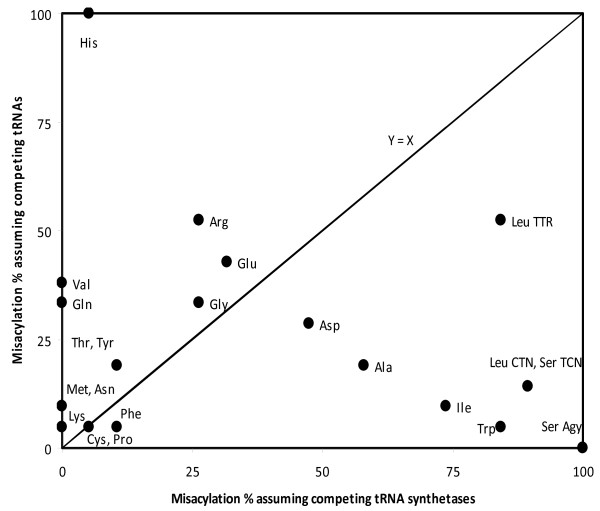
Column-versus row-analysis of TFAM's output. The y axis indicates the percentage of non-cognate amino acids with greater amino acylation potential than the cognate according to TFAM, assuming competition among tRNAs for tRNA synthetases (column-analysis of output in Table 2, see text). The x-axis is the percentage of non-cognate amino acids with greater aminoacylation potential than the cognate supposing competition among tRNA synthetases for tRNAs (row-analysis of Table 2). This graph shows that for many sense tRNAs for which classical interpretations of TFAM's output (row analysis of Table 2) yield a poor prediction of the cognate, assuming that tRNAs compete for tRNA synthetases explains apparent high misacylation rates.